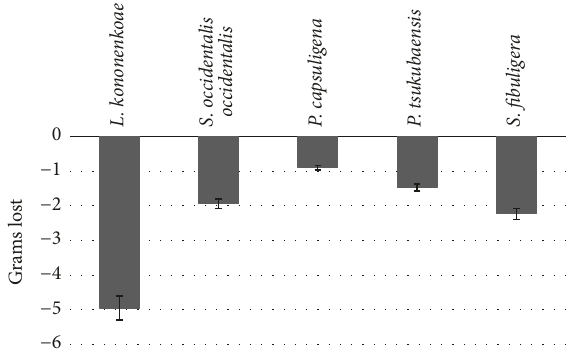
Figure 1: Substrate weight loss (mean ± standard error) taken as an indicator of yeast ability to ferment the sorghum substrate. Original substrate was approximately 160 grams (40g sorghum and 120 g sterile deionized water).